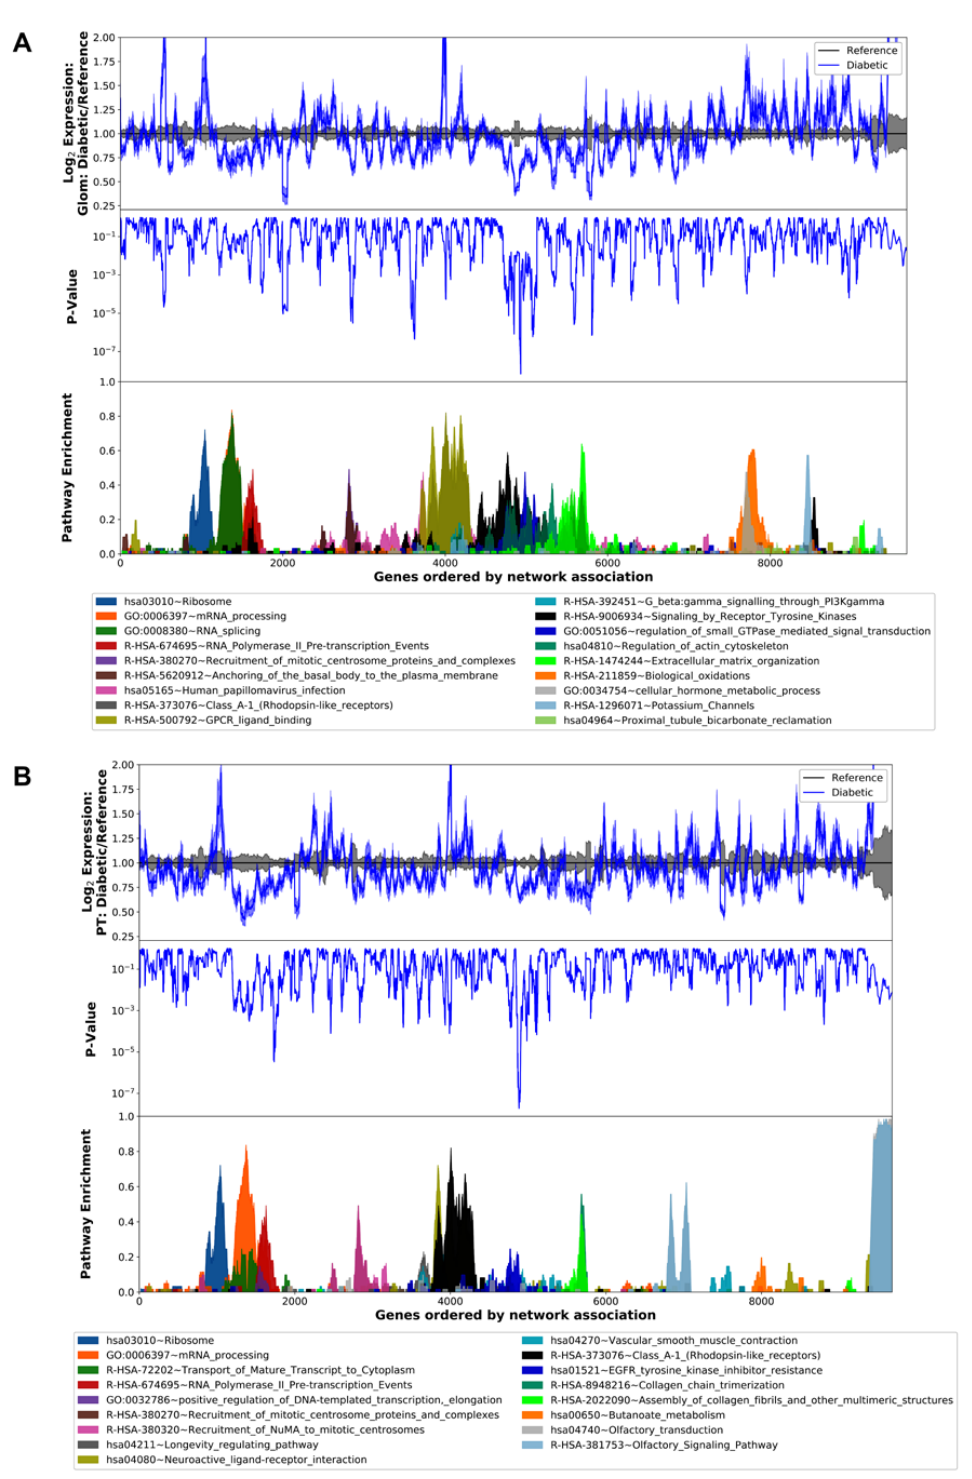
Figure 1. Transcriptogram of pathway enrichment between human diabetic and reference kidney sub- segments. X-axis: Genes ordered by network association. Y-axis: (top) Log 2 fold change expression between diabetic and reference ( A ) glomerulus and ( B ) proximal tubules. (mid) gene expression p -values. (bottom) pathway enrichment score ranging from